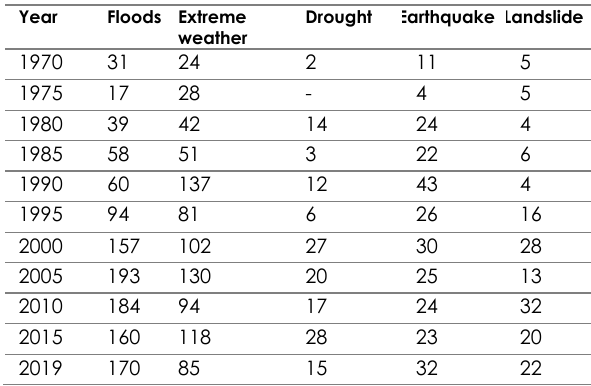
Table 1. Natural disasters were reported on a global scale between 1970 and 2019.